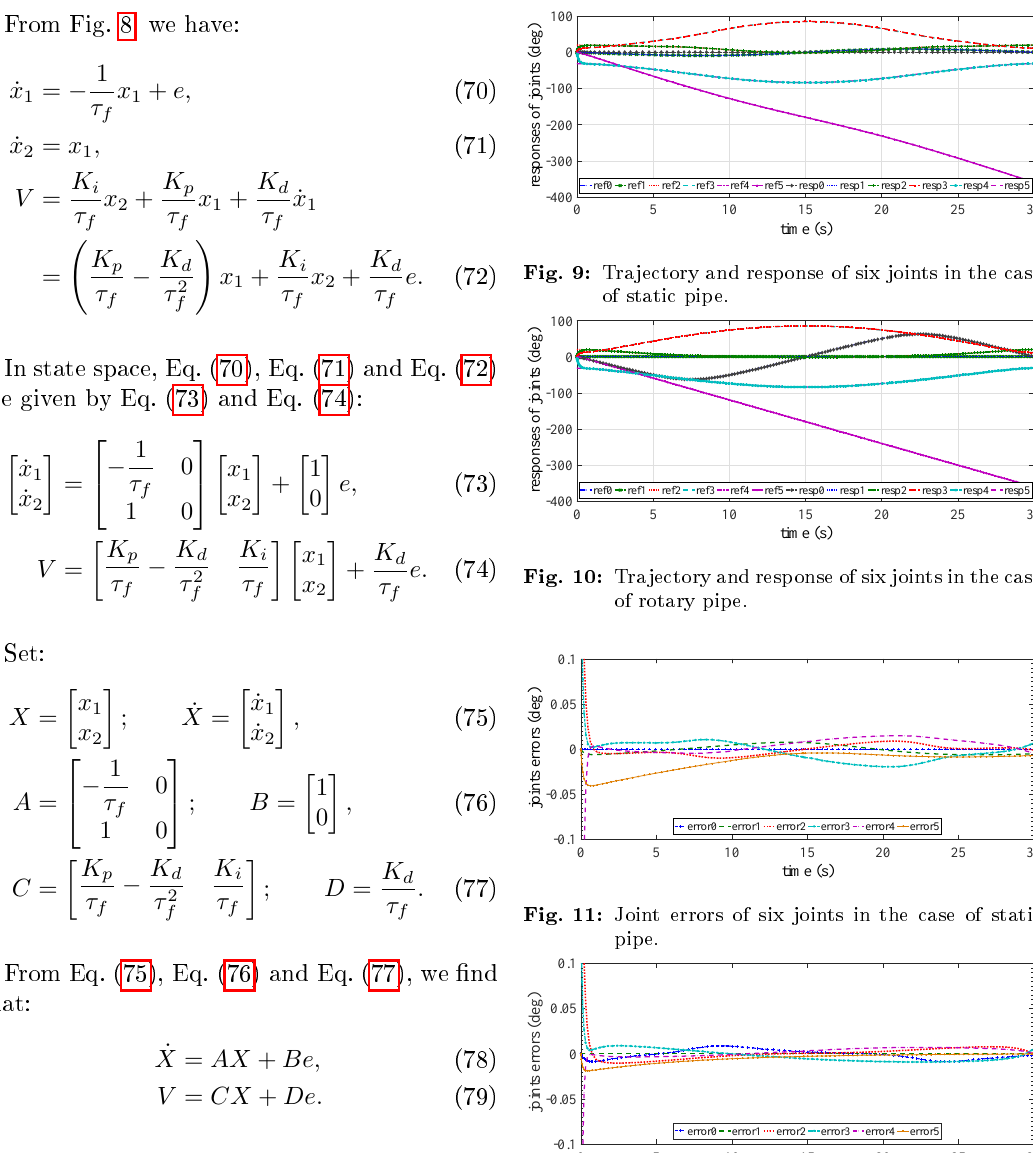
Fig. 12: Joint errors of six joints in the case of rotary pipe.